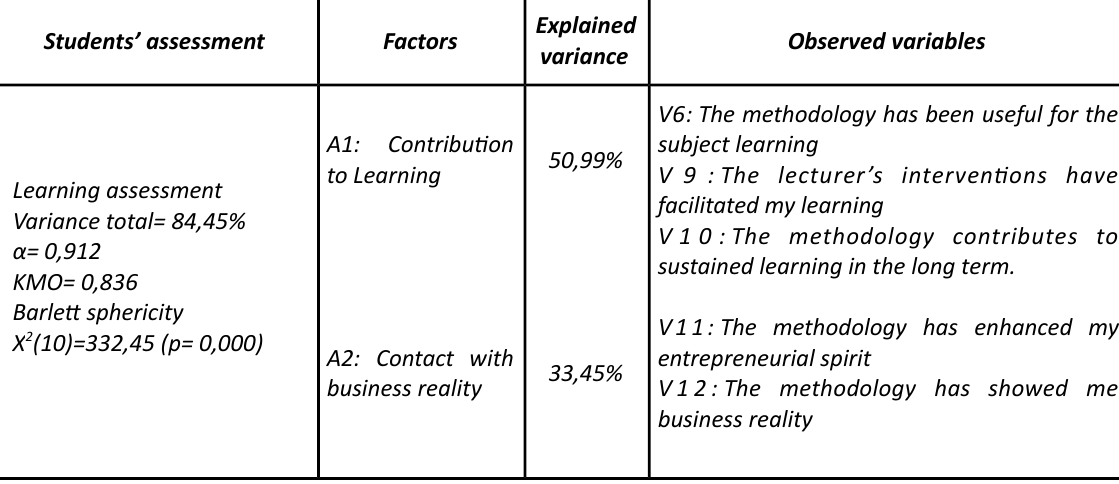
Table 4. Factor and reliability analysis